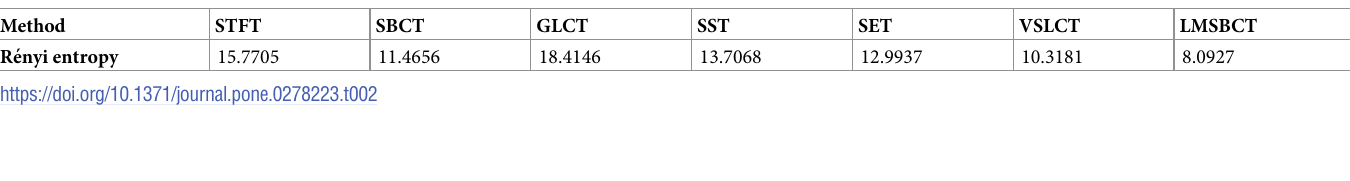
Table 2. Re´nyi entropy of different